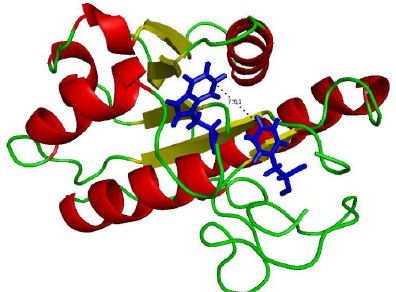
Figure 5: The distance between Trp-57 and Phe-94 (system A ).